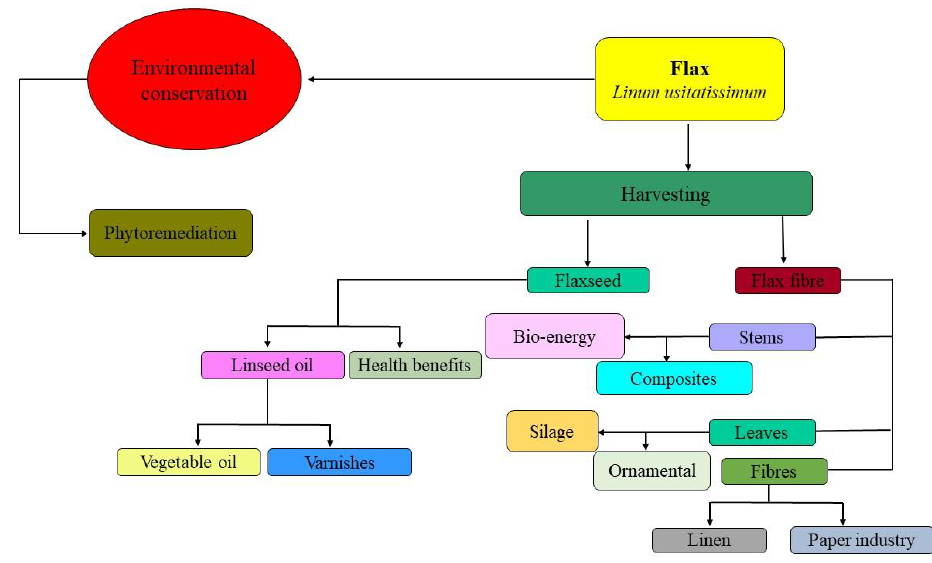
Figure 4. Flow chart diagram of flax usage.